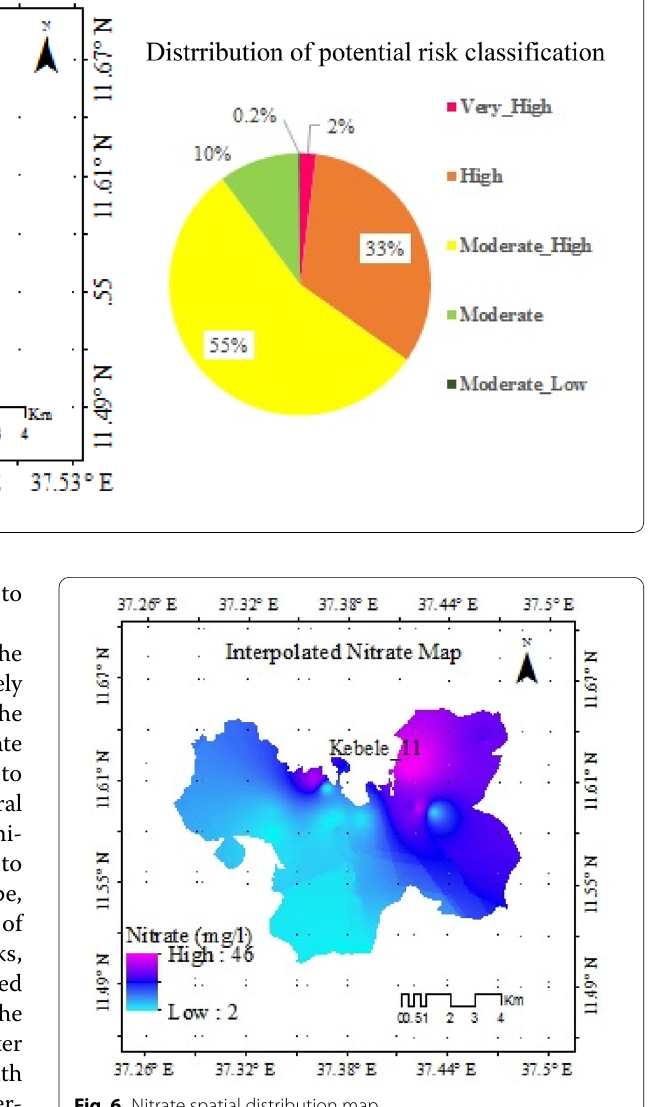
Fig. 6 Nitrate spatial distribution